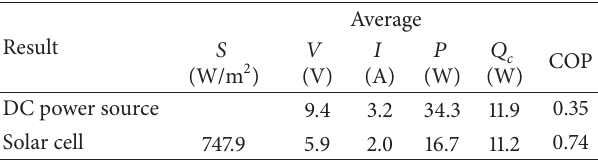
Table 2: The average cooling capacity of the semiconductor of the